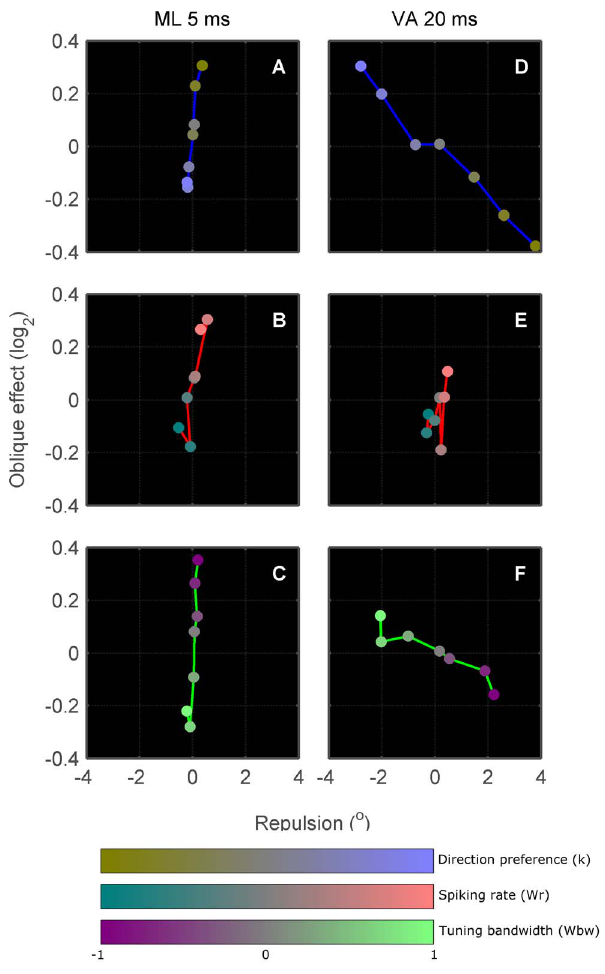
Figure 10. Isolated effects of population anisotropy. Maximum likelihood (A–C) and vector averaging (D–F) decoding of simulated anisotropic neuronal populations at integration times that produce similar perceptual precision to humans. Each coloured point quantifies the mean cardinal repulsion (Eq. 3) and oblique effect (Eq. 4) observed in 1000 instantiations of a neuronal population with a defined level of anisotropy. The colour of the point defines the level of anisotropy: mid- level (grey) RGB values correspond to neuronal populations with no anisotropies; higher blue values correspond to populations with more cardinal-preferring neurons; higher red values to lower spiking rates for neurons with cardinal preferences; and higher green values to narrower tuning curves for cardinal-preferring neurons. In each panel, the effect of varying a single anisotropy metric in isolation is shown: (A,D) variable anisotropy in direction preference ( k ) while enforcing no anisotropy in spiking rate or bandwidth ( w R =0; w BW =0); (B,E) variable anisotropy in spiking rate ( w R ) while enforcing no anisotropy in direction preference or bandwidth ( k =0; w BW =0); (C,F) variable anisotropy in bandwidth ( w BW ) while enforcing no anisotropy in direction preference or spiking rate ( k =0; w R = 0 ). Figure 11 addresses this by showing data for all combination of each anisotropy (243 models) and four different integration times. The average orientation precision produced by isotropic popula- tions at each integration time is indicated in each panel. A large family of ML decoders with red hue fall in the upper- right quadrant, suggesting that as long as anisotropies in peak spiking rate are present, neural decoding will match human perception and additional small changes in direction preference or